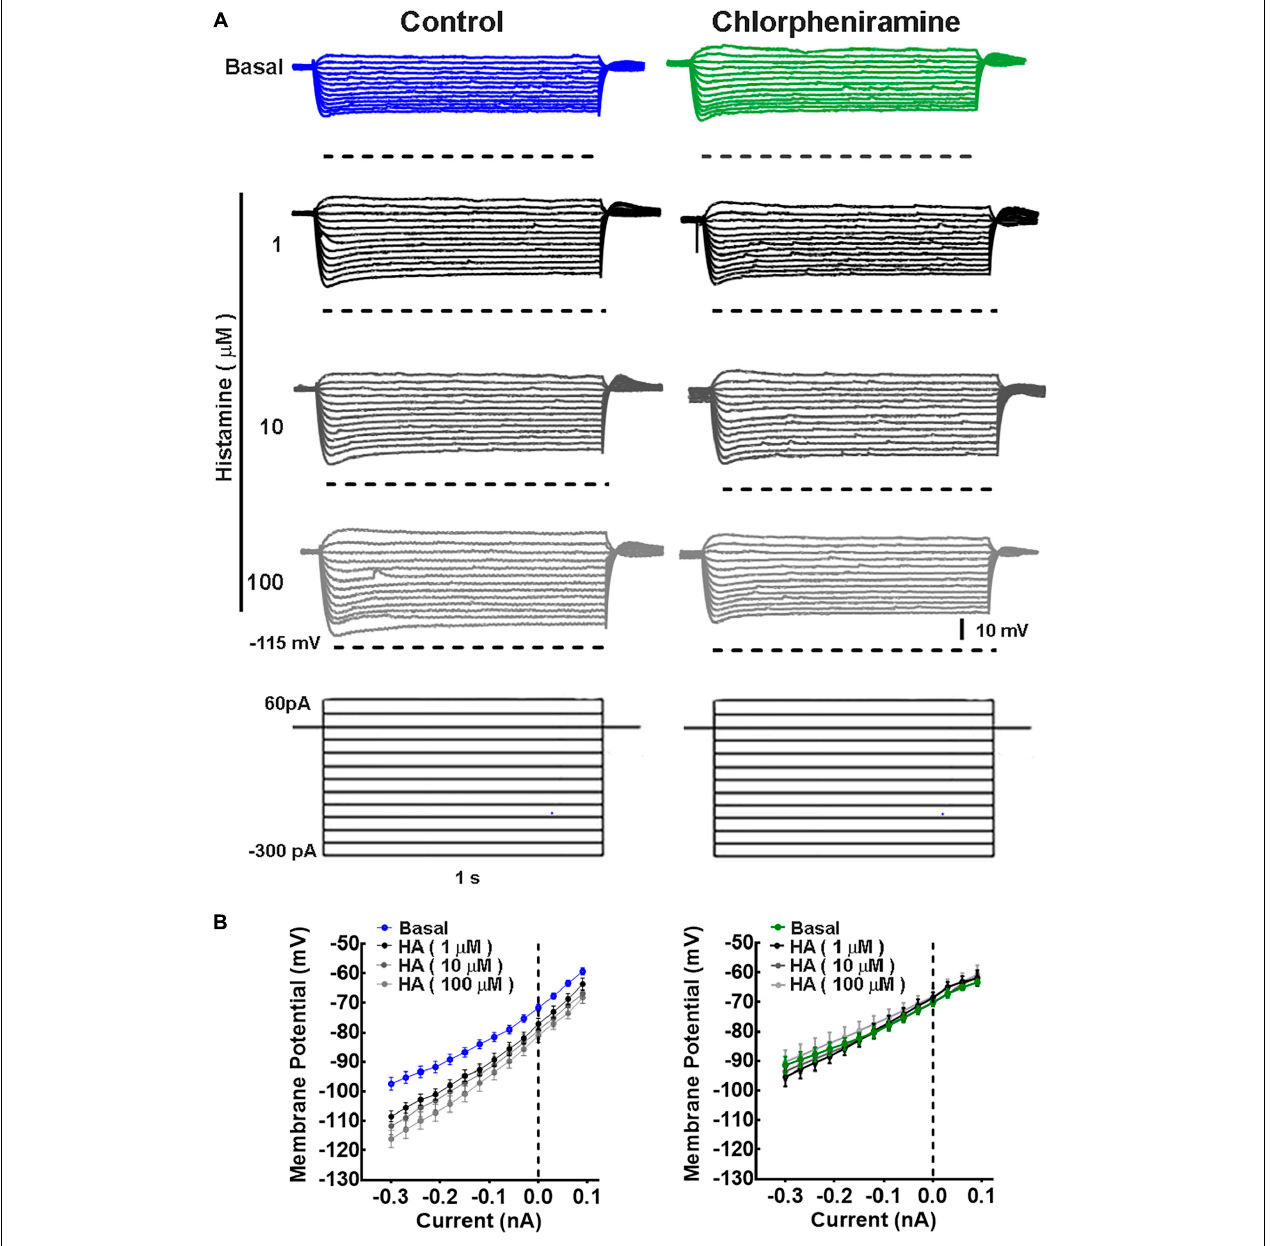
FIGURE 4 | Current/voltage relationship in deep cortical primary motor cortex neurons of 21-day-old offspring from control and chlorpheniramine-treated dams. (A) Representative traces of the changes in the membrane potential induced by a series of positive and negative current injections (1 s, 30 pA increments from − 300 to 60 pA) from deep cortical layer neurons of Control (blue) and chlorpheniramine (green) groups, in the absence (basal, upper traces) and presence of the indicated concentrations of histamine (lower traces in grayscales). (B) Quantitative analysis. Values are means ± SEM from nine neurons for each condition from 6 P21 animals from three different litters per group. The line is the best-fit linear regression for the control (blue) chlorpheniramine (green) groups under basal conditions and in the presence of histamine (grayscales). Values for the passive electrophysiological properties are given in Table 2